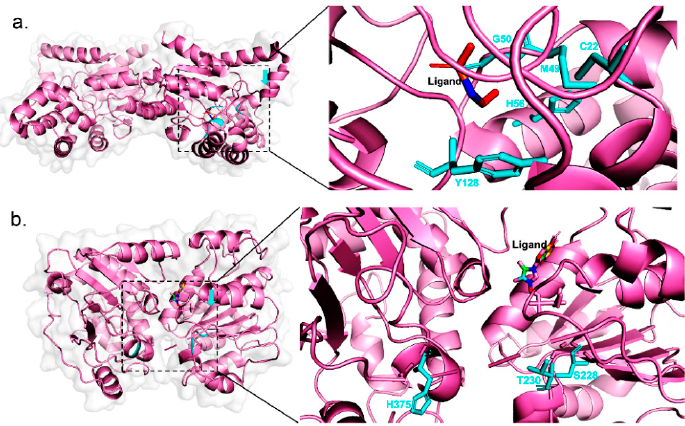
Figure 4. View of predicting effects of residue mutation on the catalytic efficiency of the phosphohy- drolysis reaction. Regions of mutated sites that decrease catalytic efficiency are highlighted in cyan on the cartoon. Ligand is shown as sticks in the rainbow. ( a ) Phosphonoacetaldehyde hydrolase (PDB:1SWW). ( b ) RNA helicase (PDB:5Z3G).